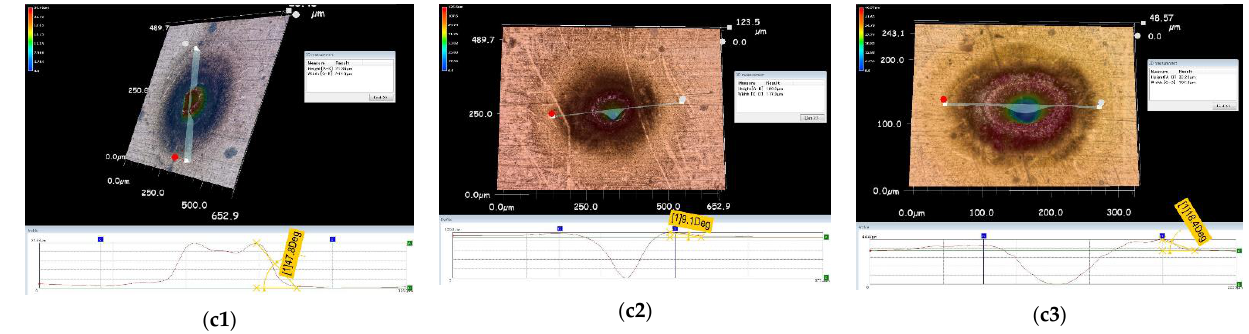
Figure A6. Additional 3D microscopy images used to measure α Figure 6c. ( c1 ) P Max -Copper; ( c2 ) P Med -Copper; and ( c3 ) P Min -Copper.